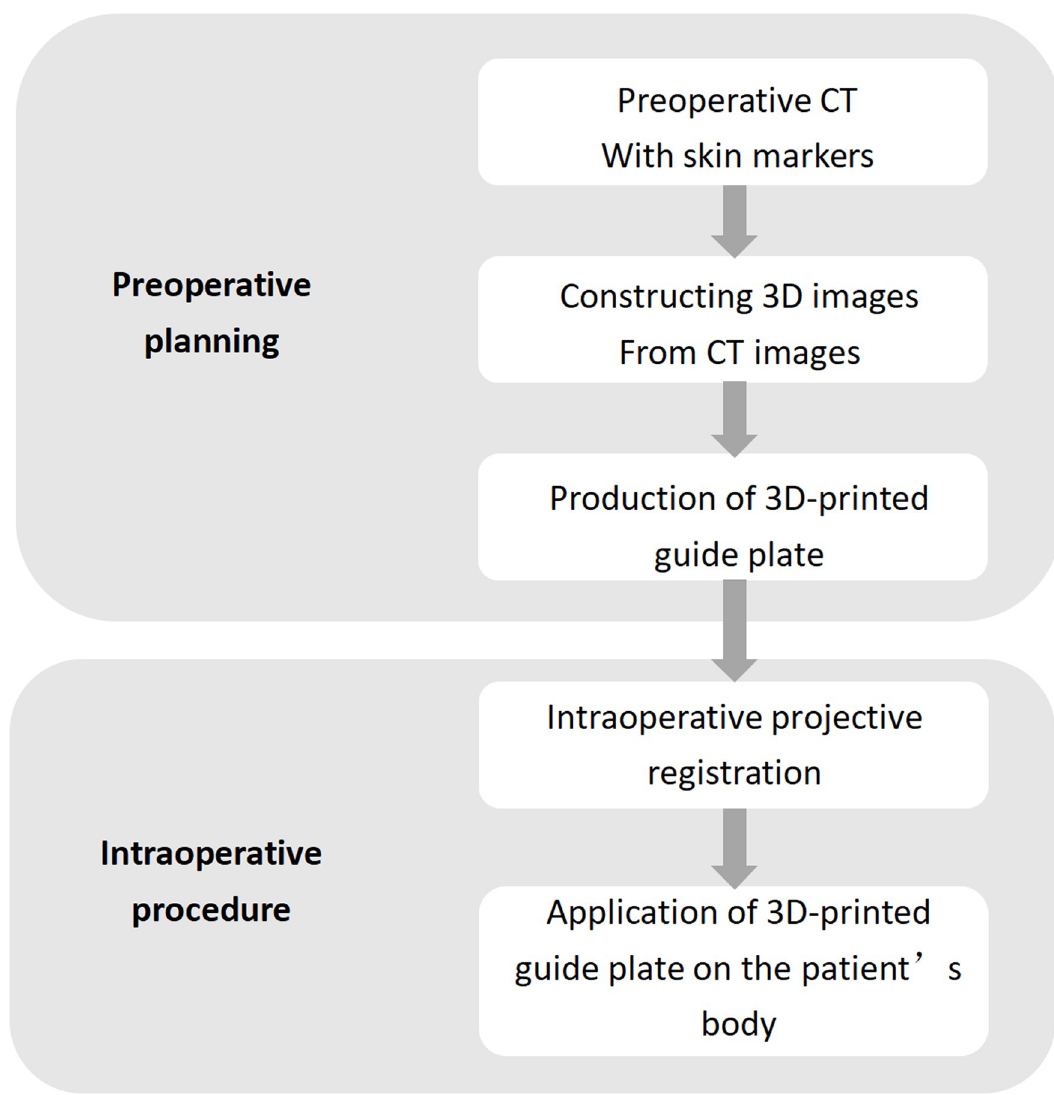
Fig 2. Procedure flow for the 3D